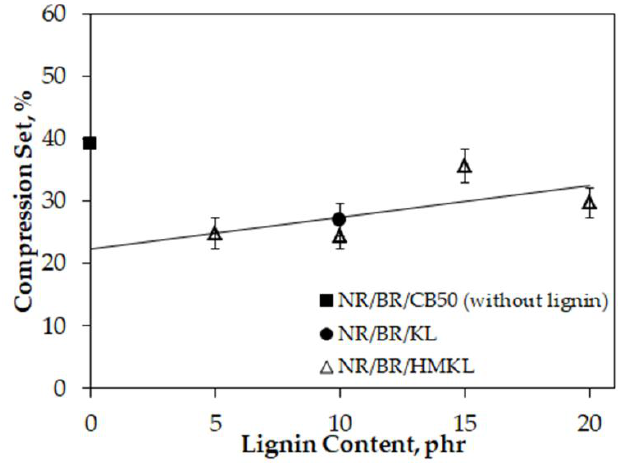
Figure 11. The e ff ect of HMKL content on the compression set of lignin-filled NR / BR compounds as Figure 11. The effect of HMKL content on the compression set of lignin-filled NR/BR compounds as obtained from compression obtained from compression tests.